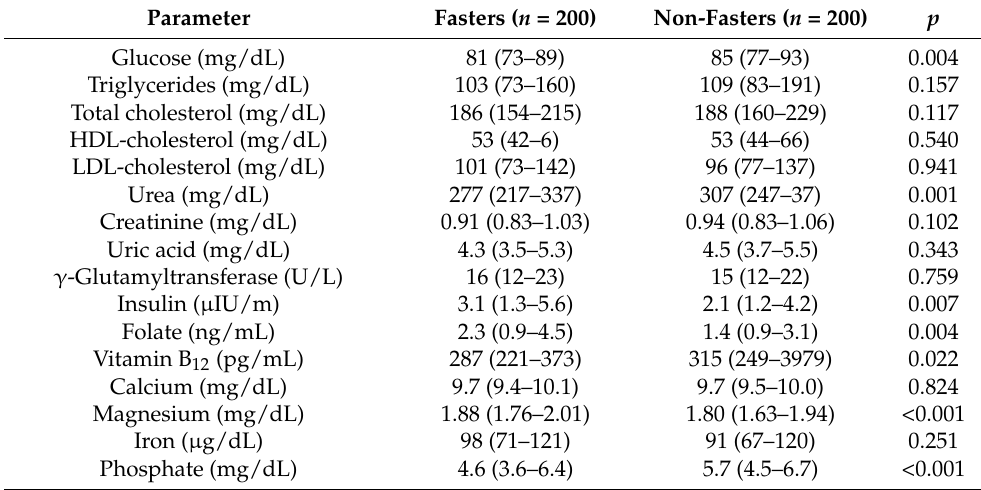
Table 4. Serum biochemical parameters of participants in the two groups (median and interquartile